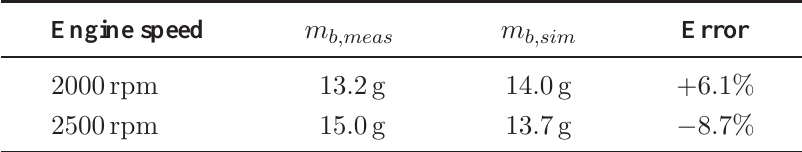
Table 2. Air mass consumption data from measurements and